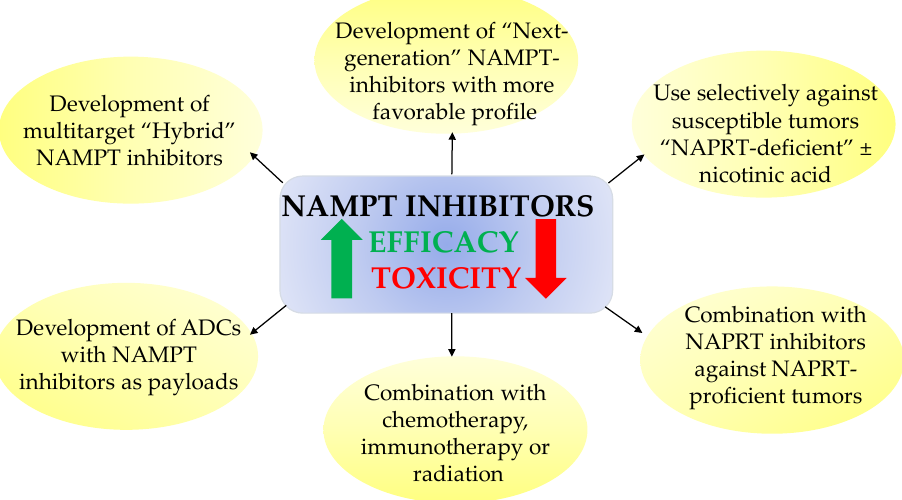
Figure 3. Schematic overview of the different strategies to improve the overall performance of NAMPT